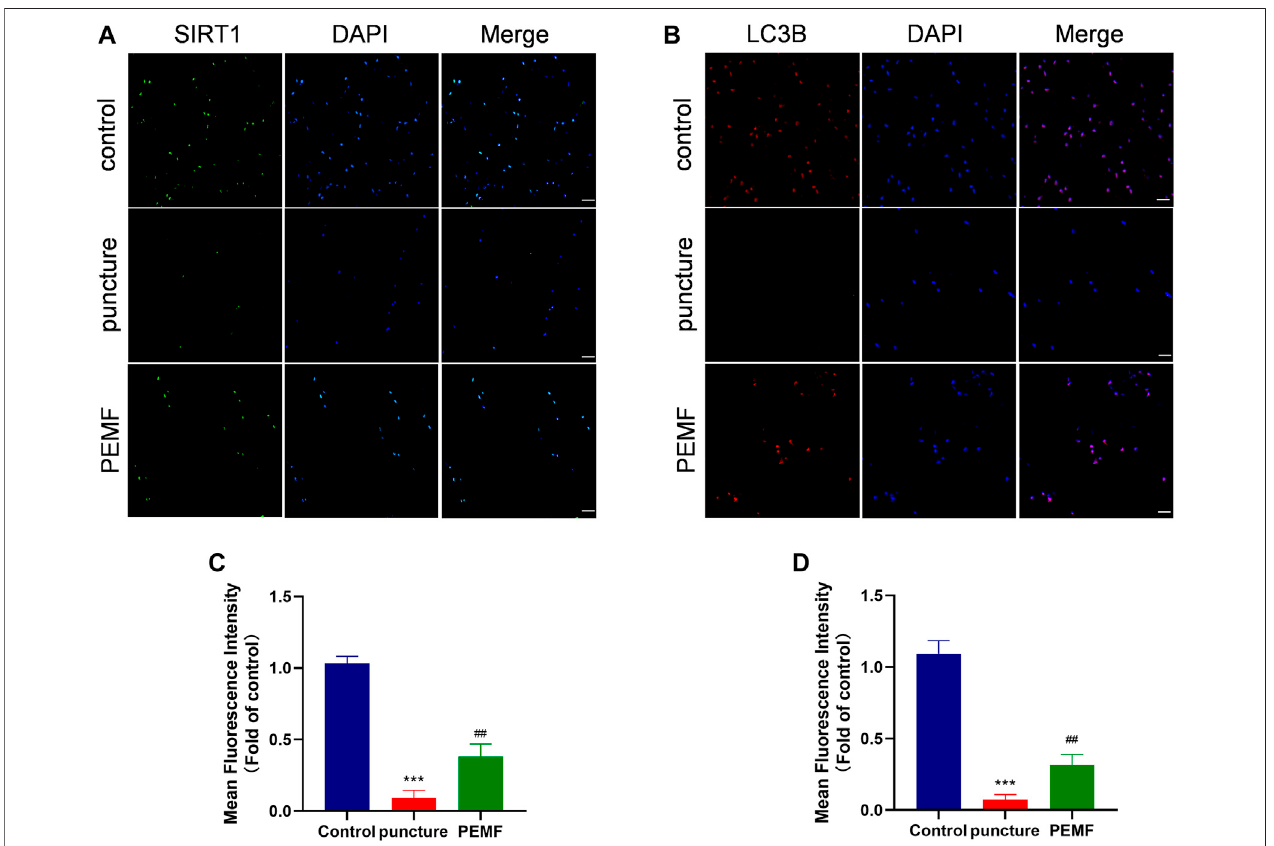
FIGURE7|(A – D) Representativeimagesofimmuno fl uorescenceandsemi-quantitativeanalysesofSIRT1andLC3B fl uorescenceintensityinIVDtissues,imaged by fl uorescence microscopy (scale bar = 50 μ m). *** p < 0.001 vs. control, ## p < 0.01 vs. puncture. Data expressed as means ±